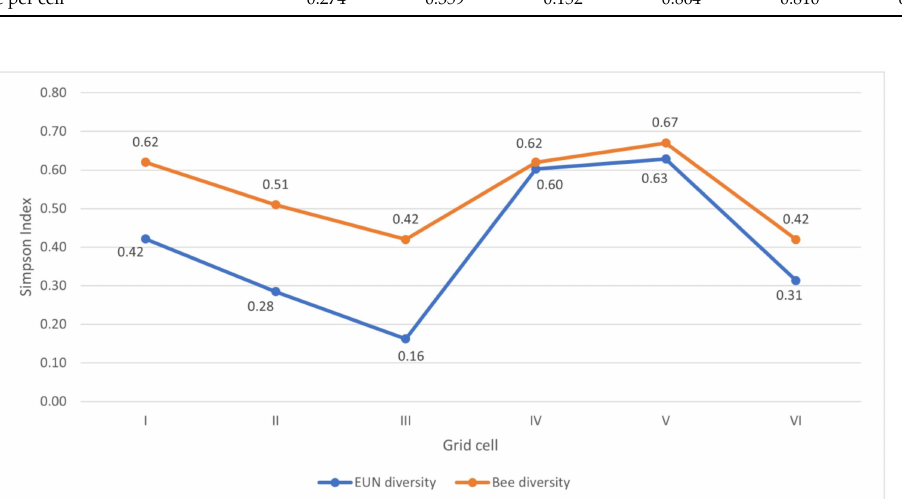
Figure 4. Similarity between trends in bee diversity (Simpson Index, orange line) and EUN diversity (Simpson Index, blue line) across the grid cells (correlation value = 0.896; p -value = 0.0155). According to just first-level indicators, the more the cells are close to the city